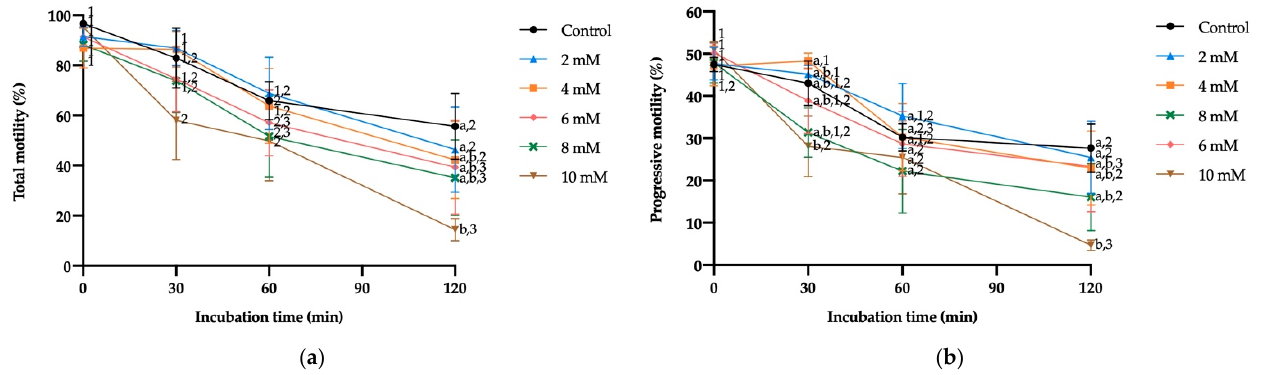
Figure 1. Mean ± SEM of total ( a ) and progressive ( b ) motility of donkey sperm exposed to reductive stress with different reduced glutathione (GSH) concentrations measured at distinct incubation times. (a,b) Different letters indicate significant differences ( p ≤ 0.05) between GSH concentrations within a given incubation time. (1–3) Different numbers indicate significant differences ( p ≤ 0.05) between incubation times within a given GSH concentration.